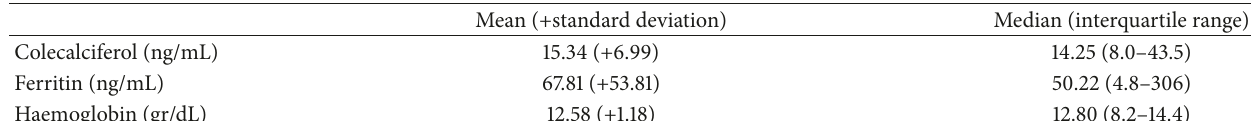
Table 2: Descriptive summary of laboratory results in trimester 1.